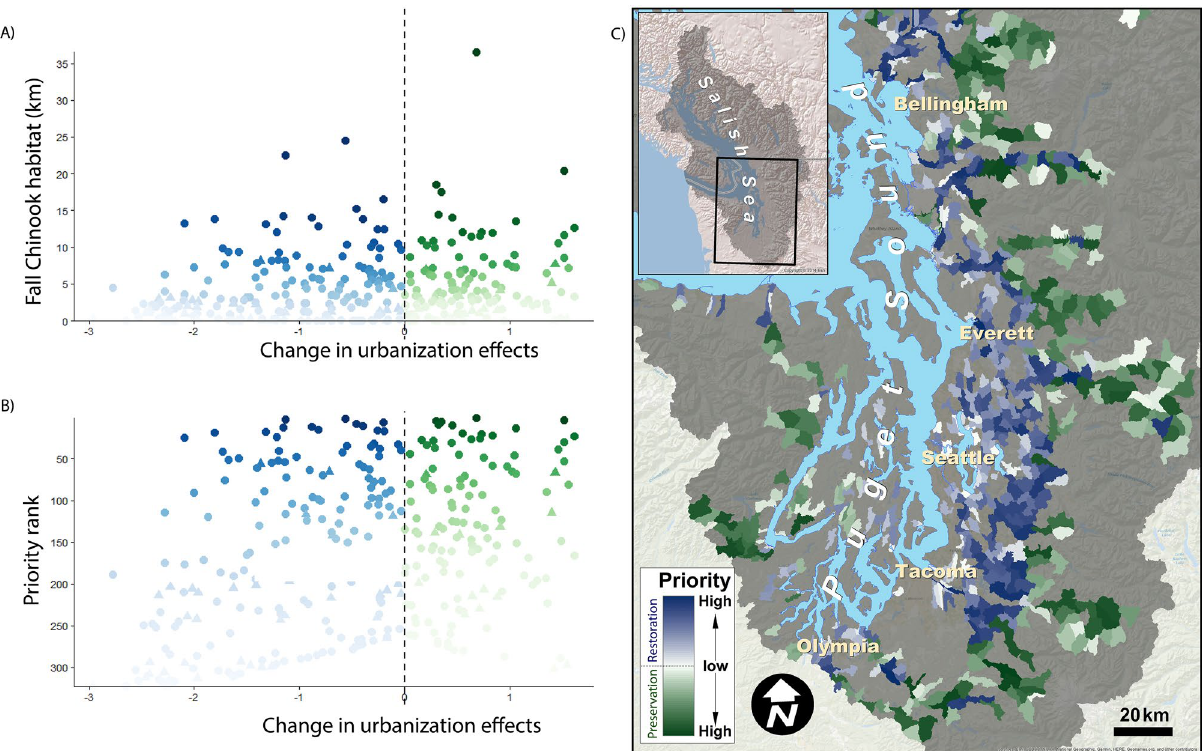
Figure 5. Prioritization of subbasins, using amount of fall Chinook habitat as the conservation metric. Subbasins in need of restoration (i.e., Δ Z < 0, N = 479) are shown in blue; those that are candidates for preservation (Δ Z > 0; N = 195) are shown in green, with darker colors representing higher priority. We calculate prioritization scores for each subbasin shown in ( A ) and use scores to rank all locations. For both restoration and preservation basins, a lower prioritization score is associated with higher priority (see “Prioritizing sites for conservation or restoration action” in “Methods”). Subbasins are ranked by priority on the y -axis in ( B ) (1 = top priority). ( C ) shows subbasin locations. Chinook habitat is quantified as kilometers of stream within the subbasin. Map generated using Esri ArcMap software (v. 10.1, https